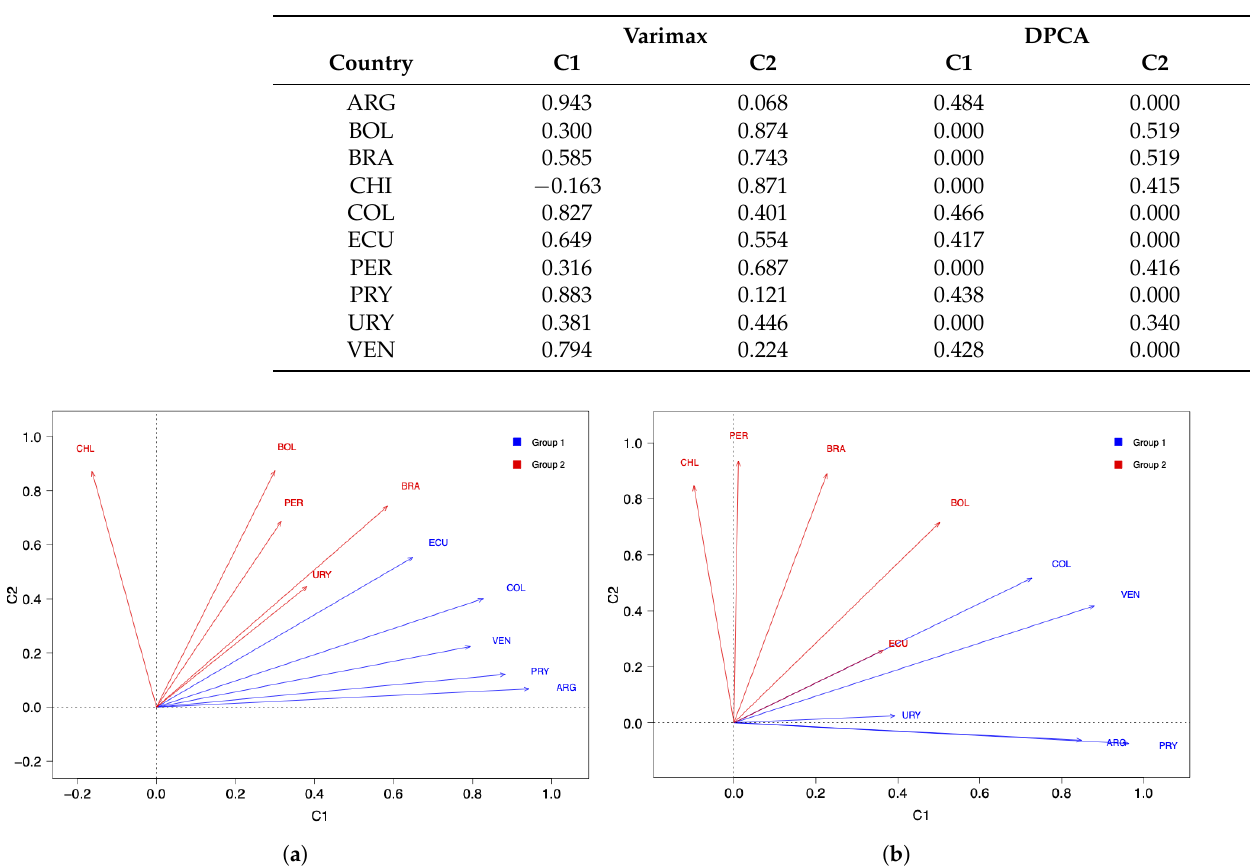
Table 2. Loading matrices for data of the number of COVID infected cases with two components (C1 and C2) for the indicated country and method.